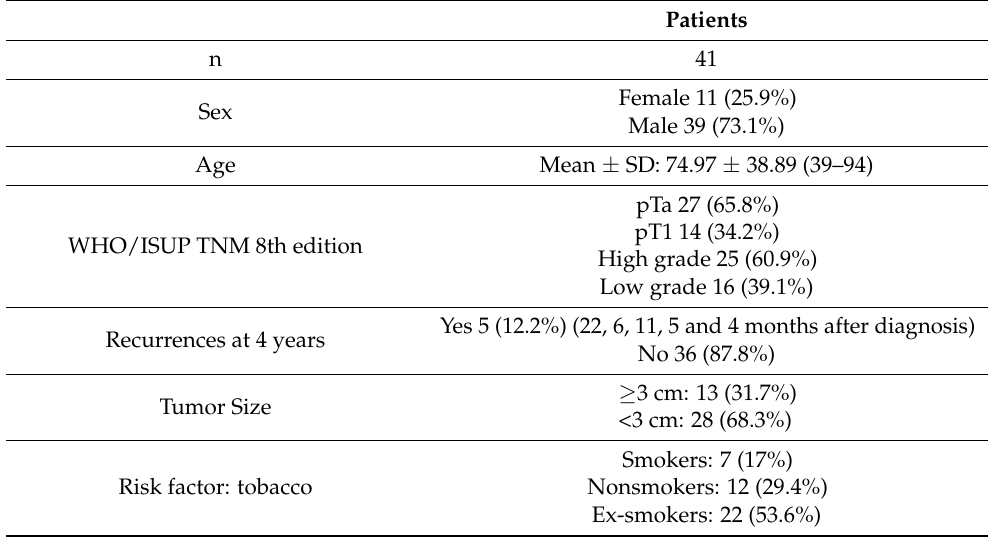
Table 1. Demographic and clinical characteristics of the study